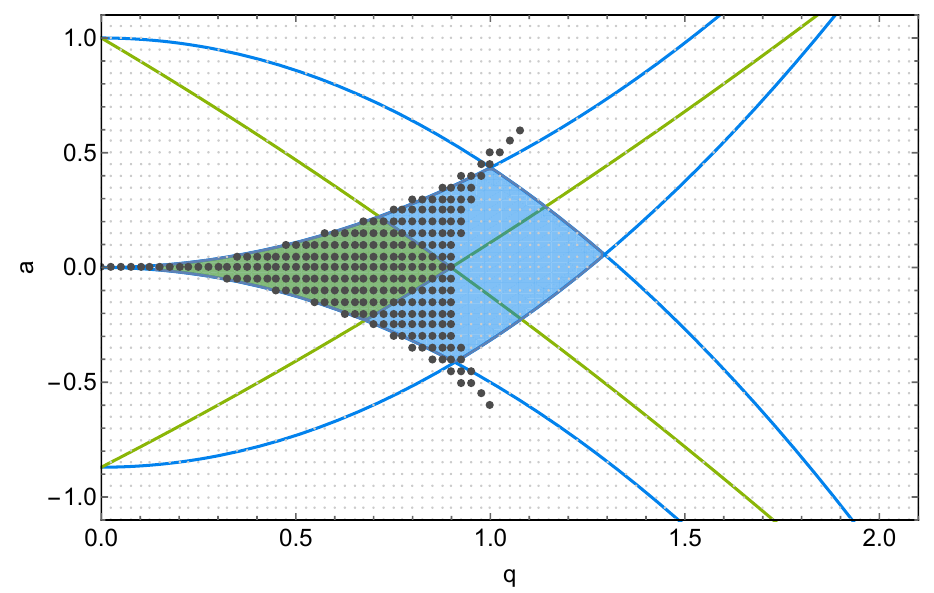
Figure 7. Stability diagram of the Paul trap, characterized by a coupling angle of 45 ◦ between the RF electrodes and endcaps’ axes. The black thick dots represent the { q , a } pairs for which the Paul trap (described by a system of coupled Mathieu equations) is stable, whereas the small gray dots indicate values of parameters for which the trap is unstable. The blue curves, calculated with the multiple-scale perturbation theory, enclose a stability region that is wider than the numerically estimated one, yet well describing the stability behavior for small values of q . The green area is the stability region of the corresponding uncoupled